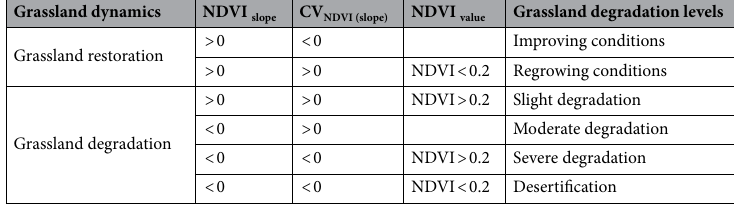
Table 1. Degrees of grassland degradation or